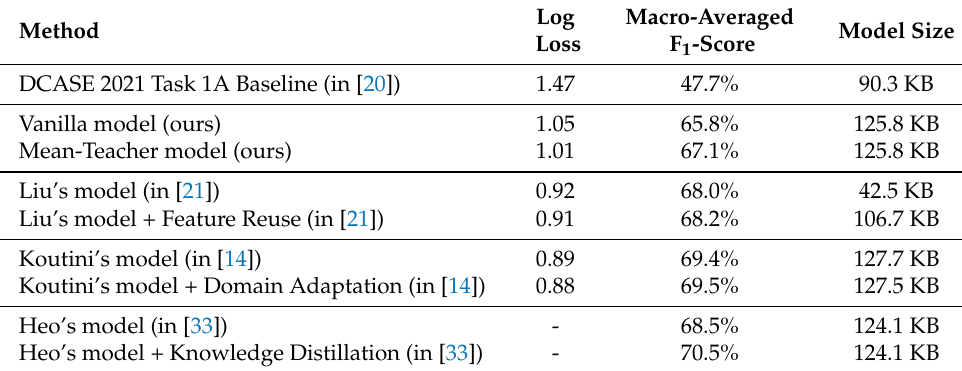
Table 3. Performance comparison with the state-of-the-art performances. All performances are presented using the values reported in referenced papers.